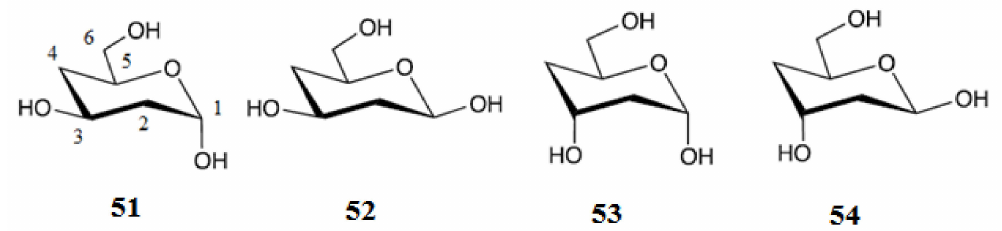
Figure 26. Four model carbohydrates used for the establishment of the dihedral angle dependencies